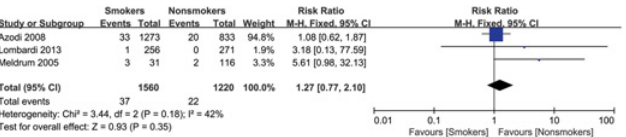
Fig 4. Forest plot of the association between smoking and the risk of implant dislocation after total hip